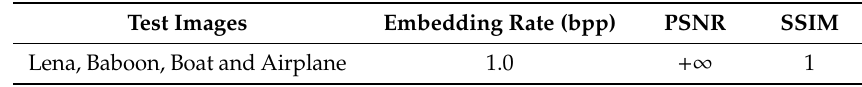
Figure 10. Performance comparison on the test image Lena for compared schemes Method-1 [9], Method-2 [10], Method-3 [12], Method-4 [11], Method-5 [16], Method-6 [24]. For Methods-1–5 [9–12,16], PSNR decreased with the increase in embedding rate. For Method-6 [24], PSNR was +∞ dB and was independent of the embedding rate with maximum embedding rate of 1